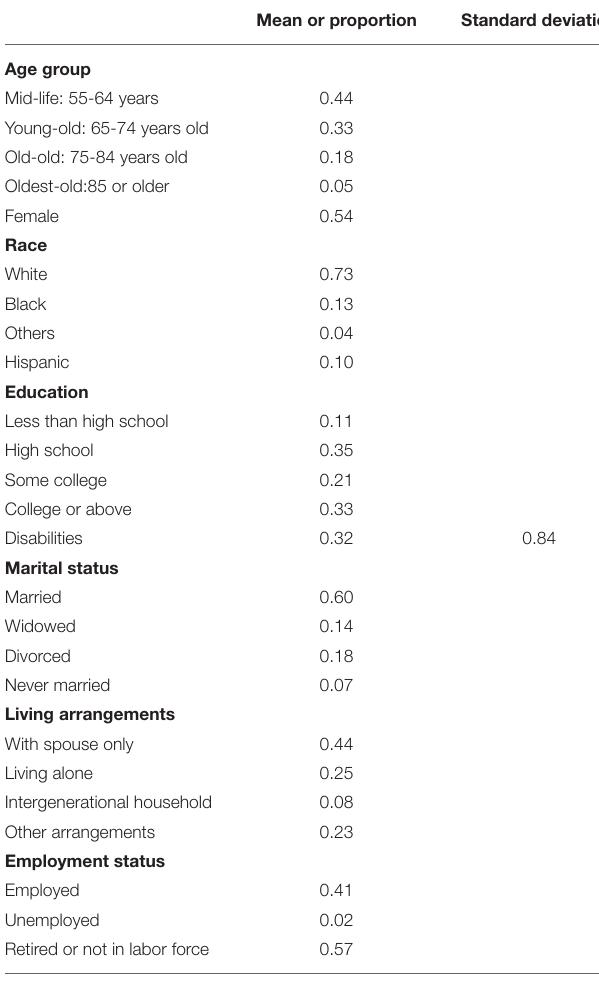
TABLE 1 | Descriptive statistics of selected demographic characteristics the sample (weighted, N =